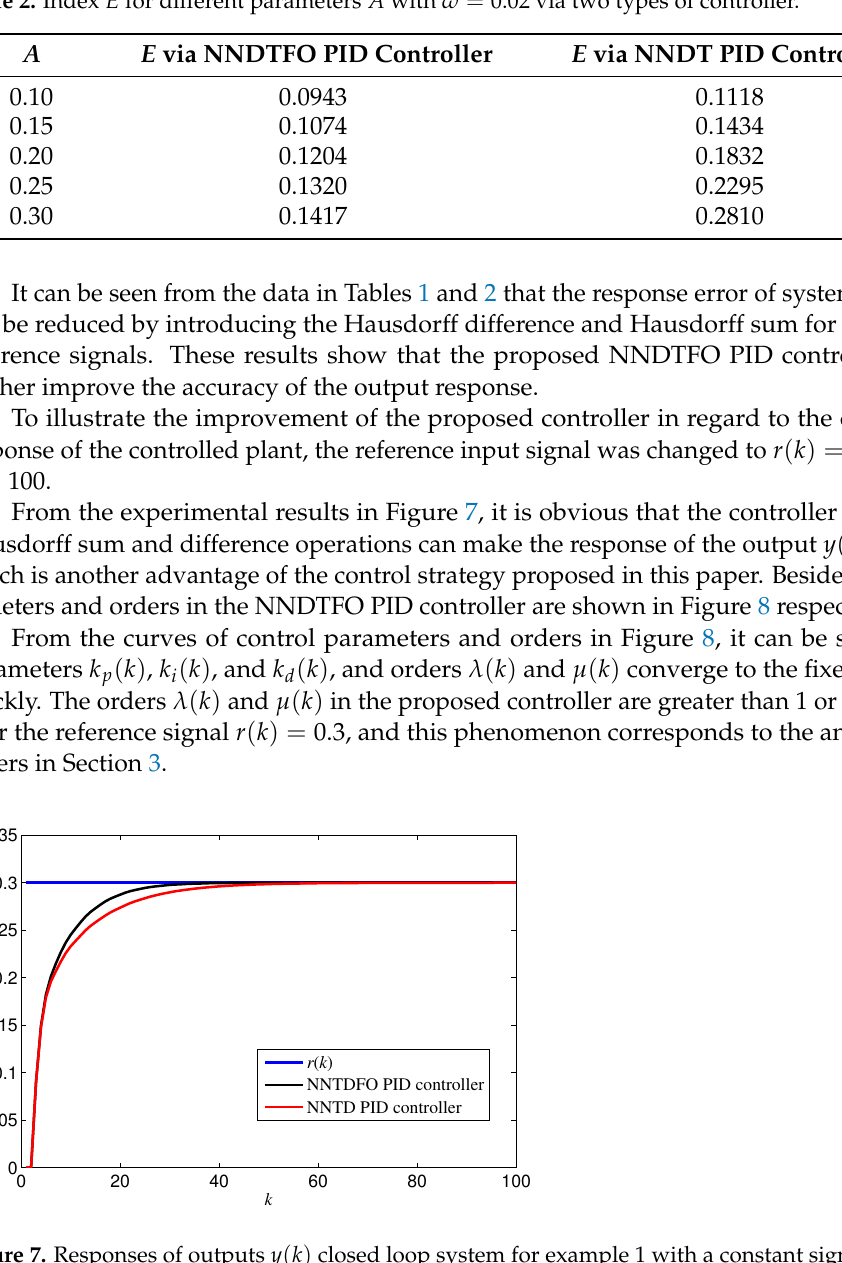
Figure 7. Responses of outputs y ( k ) closed loop system for example 1 with a constant